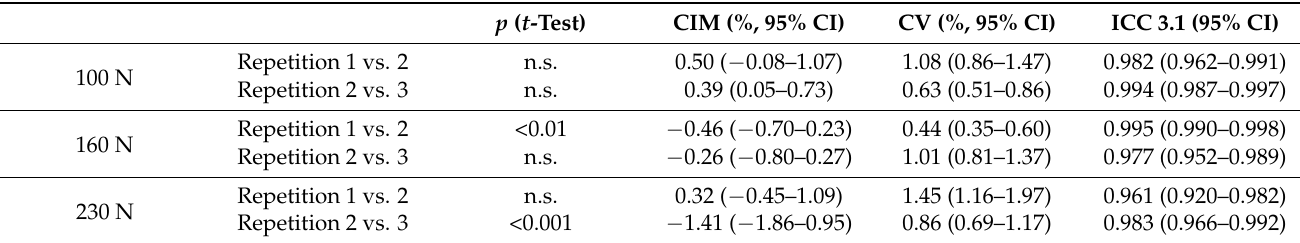
Figure 6. The orange and blue data points represent the calculated mean curvature from the PyzoFlex ® data (mean ± SD) of the middle sensor row for the corresponding segments (S 1 to S 7 ).